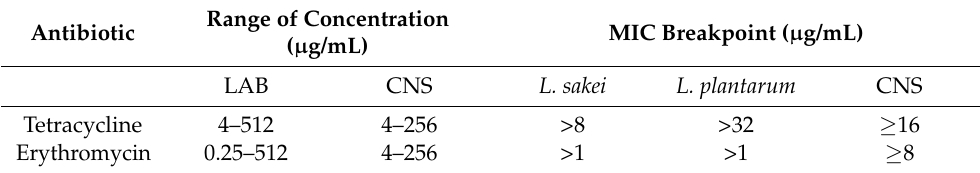
Table 1. Antibiotics used, range of concentrations ( µ g/mL) for MIC determination, and break- point